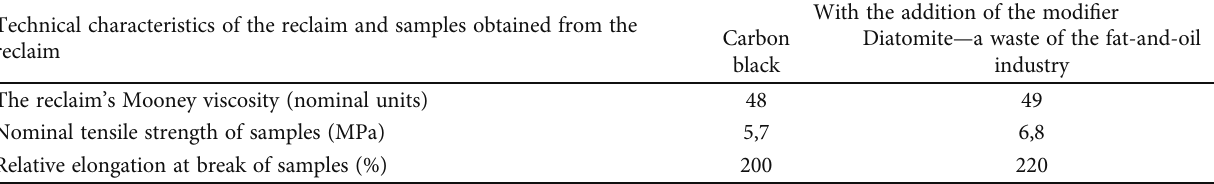
Table 6: The technical characteristics of the reclaim and